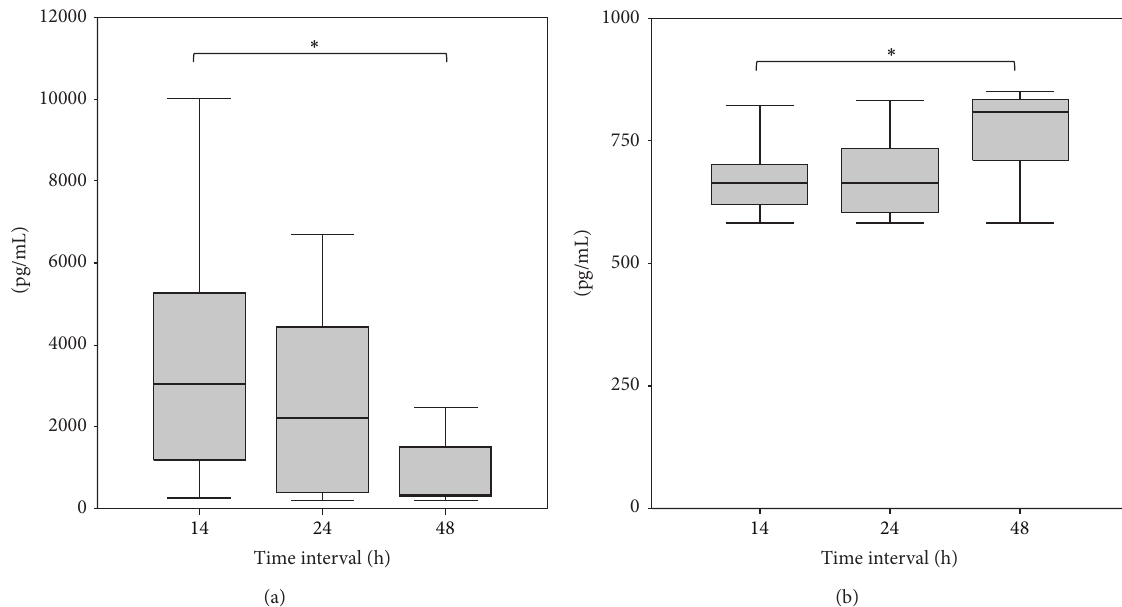
Figure 2: (a) Decreasing fracture hematoma concentration of IL-6, ∗ = 𝑃 < 0.05 between 14h and 48 h. (b) Increasing fracture hematoma concentration of IL-8, ∗ = 𝑃 < 0.05 between 14 h and 48 h. Table 2: Comparison of serum and fracture hematoma concentrations on 14h, 24h, and 48 h. 14 h Serum IL-6